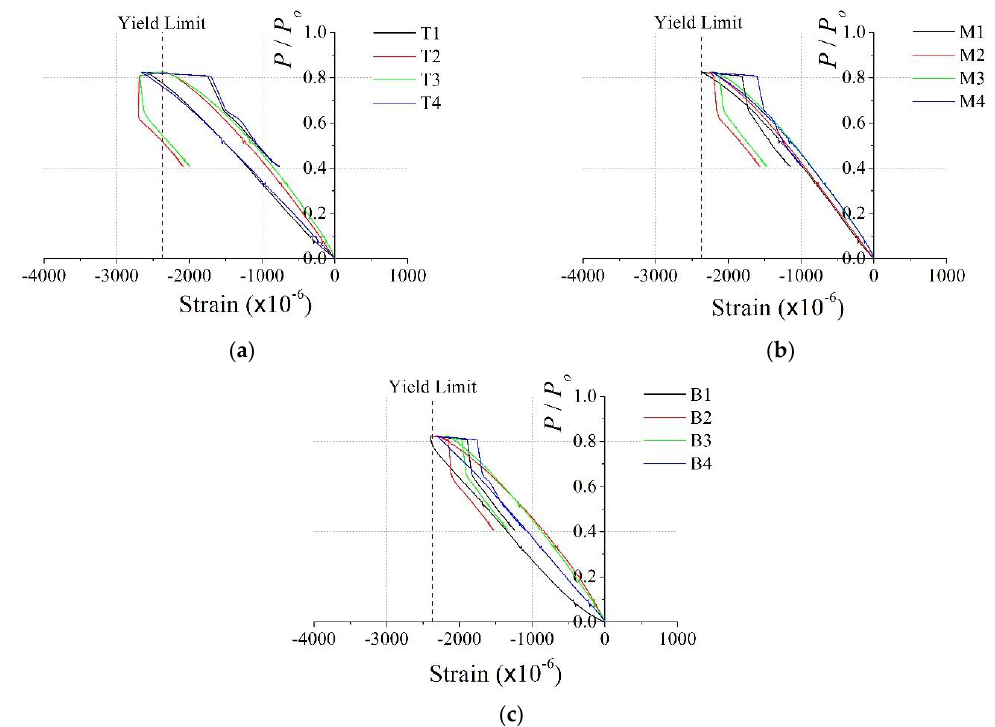
Figure 9. Dimensionless axial load vs. vertical stain for PAL15: ( a ) top (T1 – 4); ( b ) middle (M1 – 4); ( c ) bottom (B1 – 4).